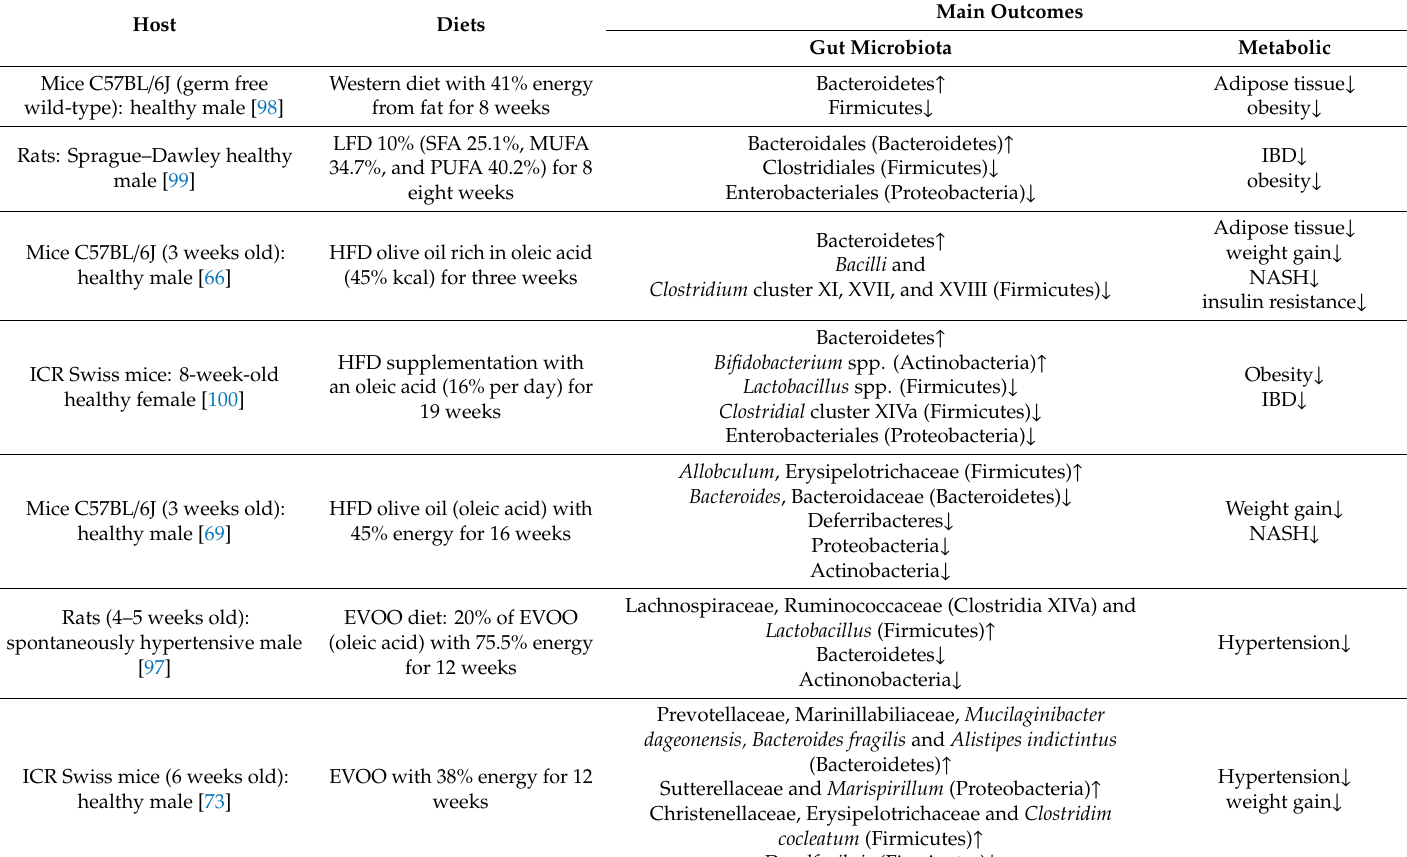
Table 3. E ff ects of monounsaturated fatty acids intake on gut microbiota composition and metabolic outcomes in animal